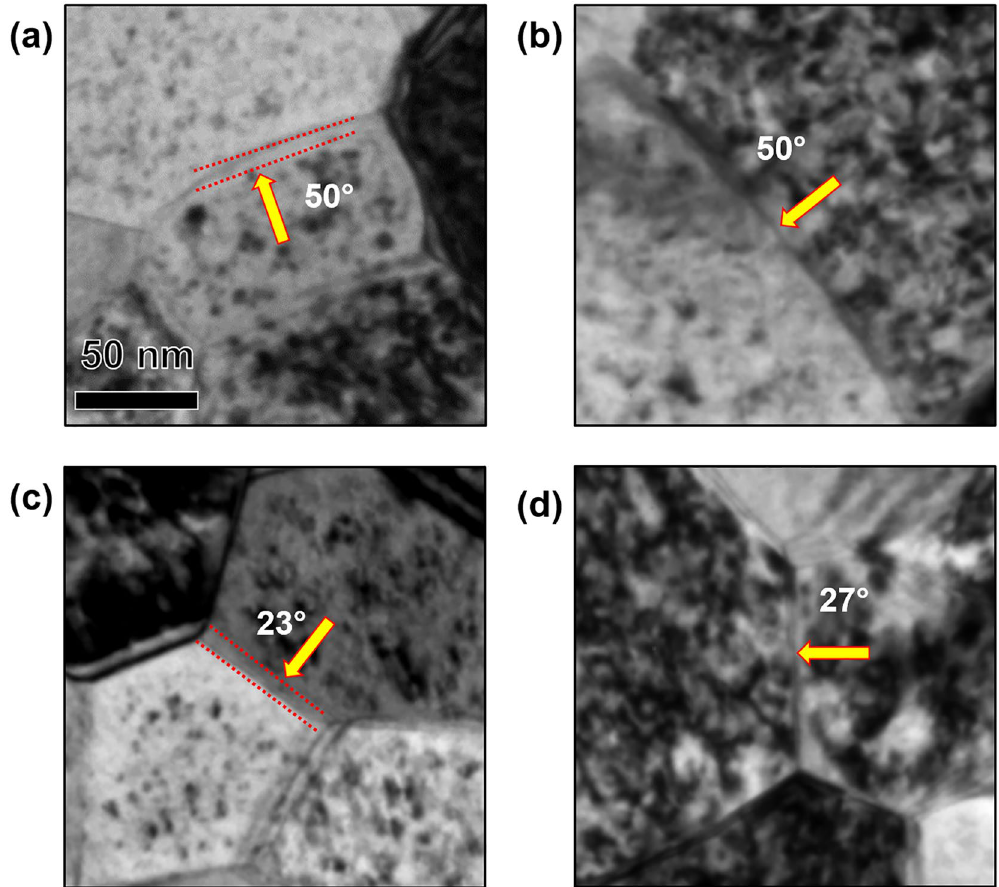
Figure 7. Bright-field TEM images of ( a ), ( c ) loop denuded and ( b ), ( d ) non-denuded HAGB of irradiated nanocrystalline Fe at the end dose (2.87 × 10 21 ion.m − 2 ). Misorientation angles are labelled in the Figure.